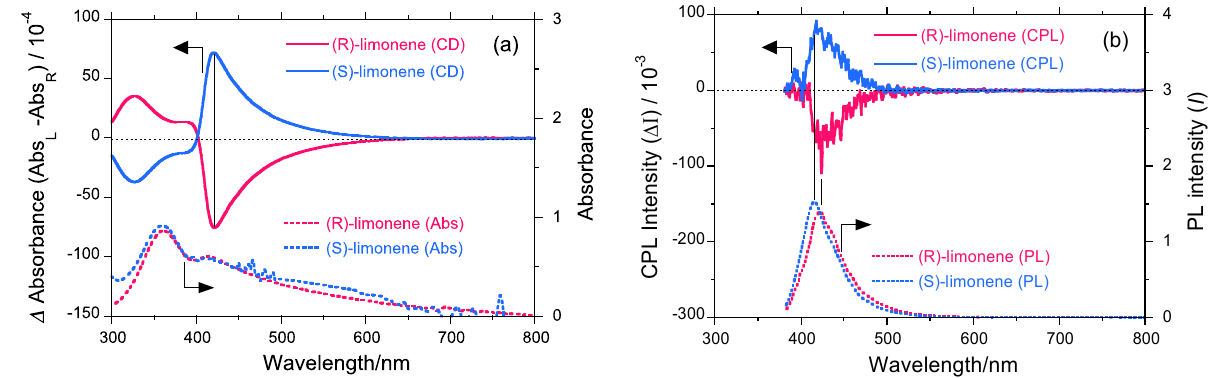
Figure 5. ( a ) The raw CD and UV-vis (1.0 × 10 −5 mol L −1 ) and (b) CPL and PL spectra of PF8P2 aggregates generated under optimized chloroform/limonene/methanol (=0.3/1.1/1.6 (v/v/v)) conditions at 25